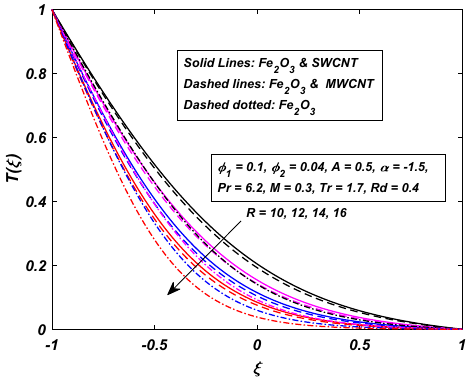
Figure 6. Influence of R on T ( ξ ).